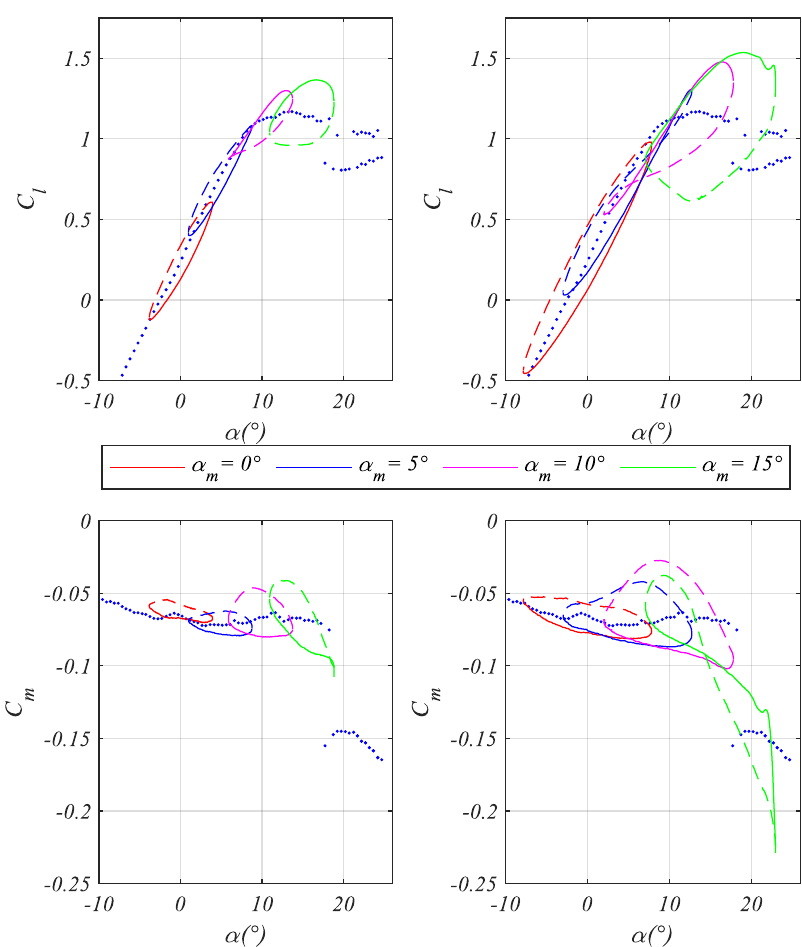
Figure 13. Lift and pitching moment, Re = 0.5 × 10 6 , k = 0.1. Left column: ∆ α = 4 ◦ , Right column: ∆ α = 8 ◦ . Dotted line corresponds to steady case.